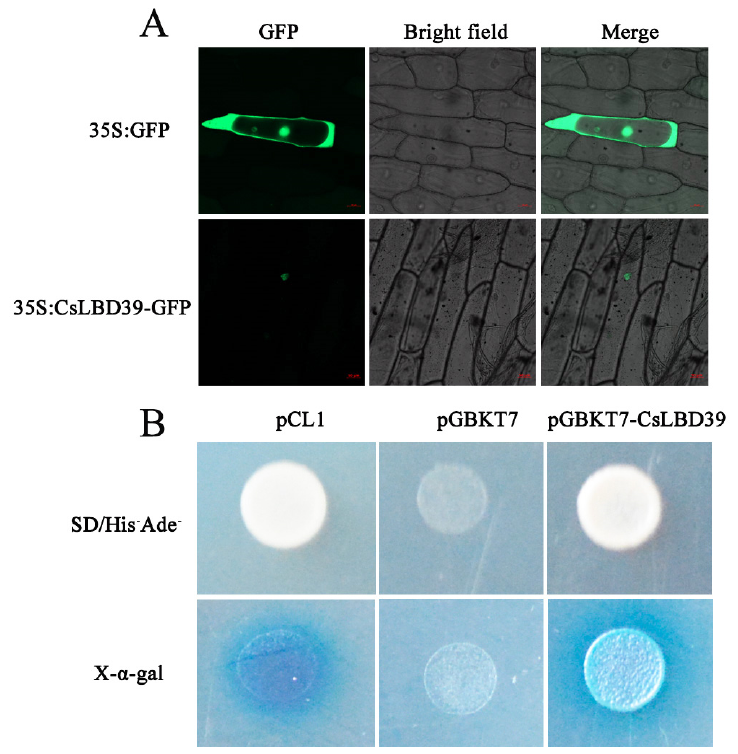
Figure 3. Subcellular localization and transcriptional activation activity of CsLBD39. ( A ) Subcellular localization of CsLBD39 in onion epidermal cells. Scale bars = 50 µ m. ( B ) Transcriptional activation activity of CsLBD39 in yeast.